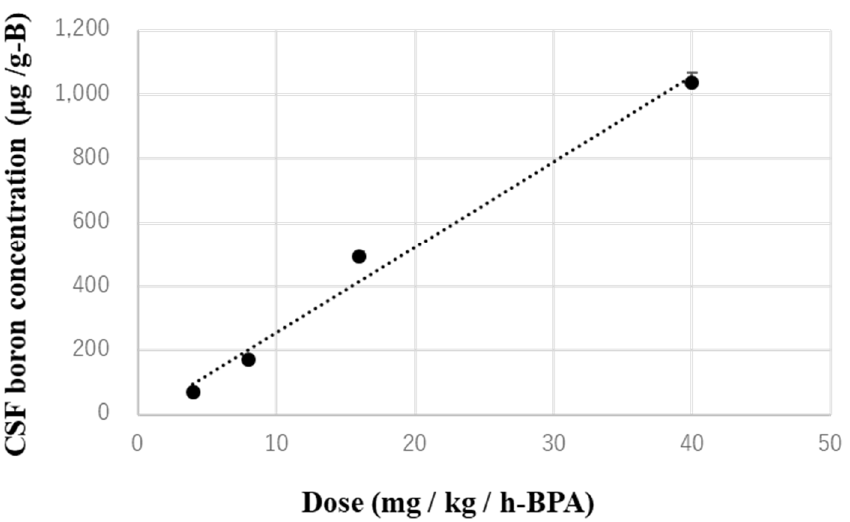
Figure 3. Average boron concentration in CSF from 40 to 60 min after starting infusion for each dose. The dotted line is the fitting curve of the measured average boron concentrations.